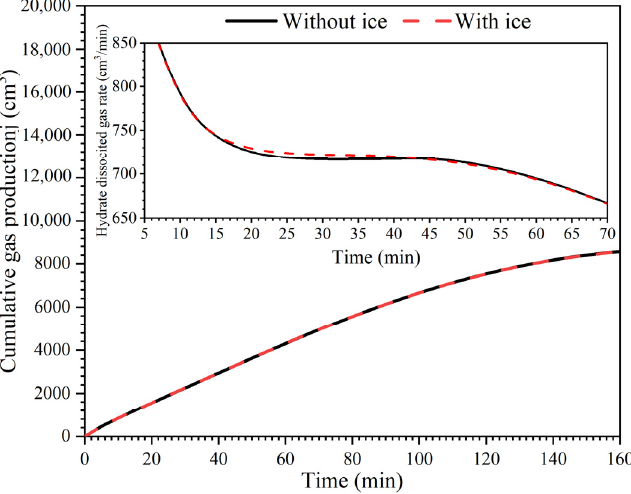
Figure 9. Cumulative gas production and hydrate dissociated gas rate with or without ice.